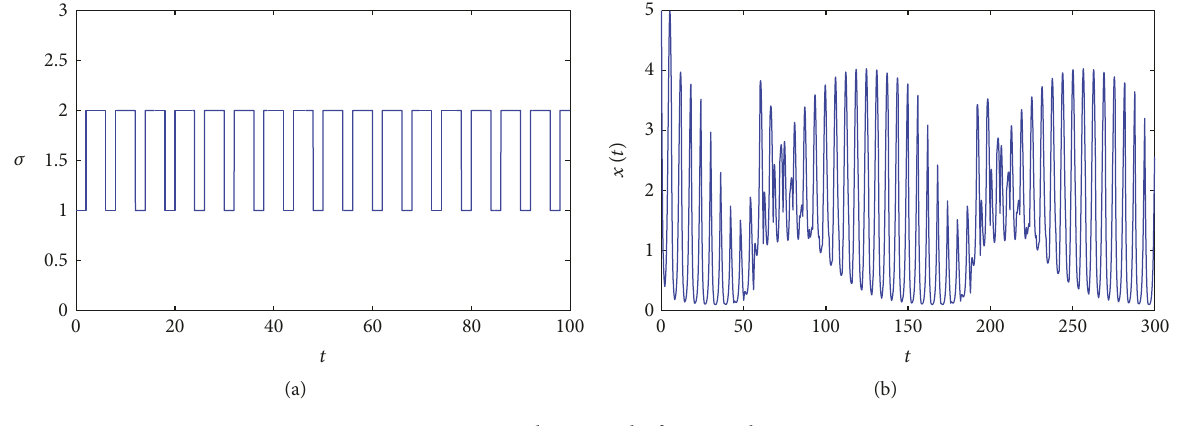
Figure 1: Simulation results for Example